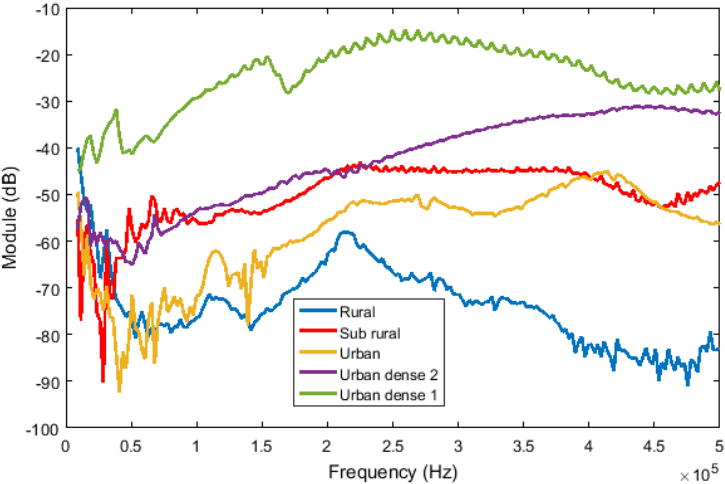
Figure 16. Results of transfer function analysis for each site.